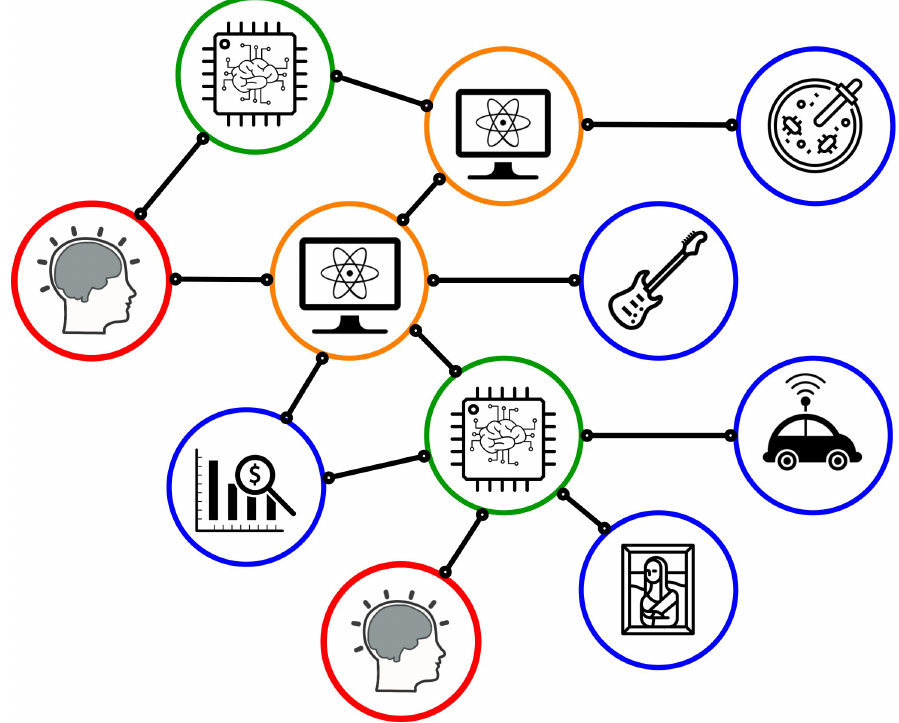
Figure 1. Quantum brain